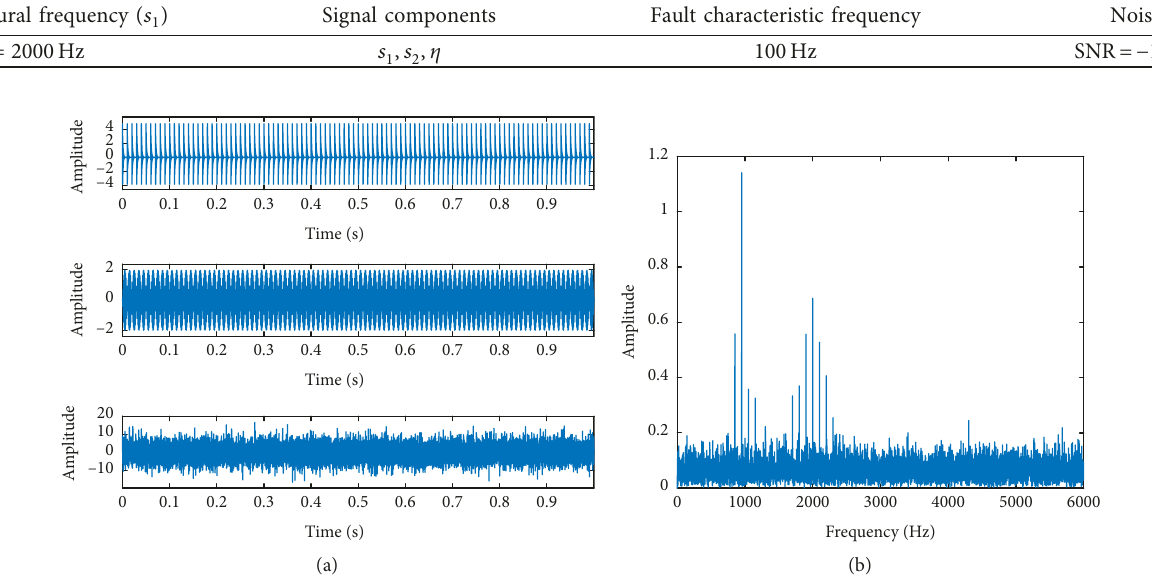
s 2 ; (c) the simulated signal